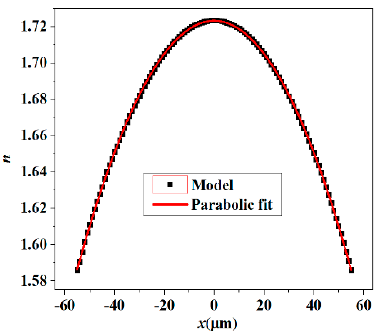
Figure 4. Simulated effective refractive index distribution curve across the LC microlens at V on = 4.8 V rms .